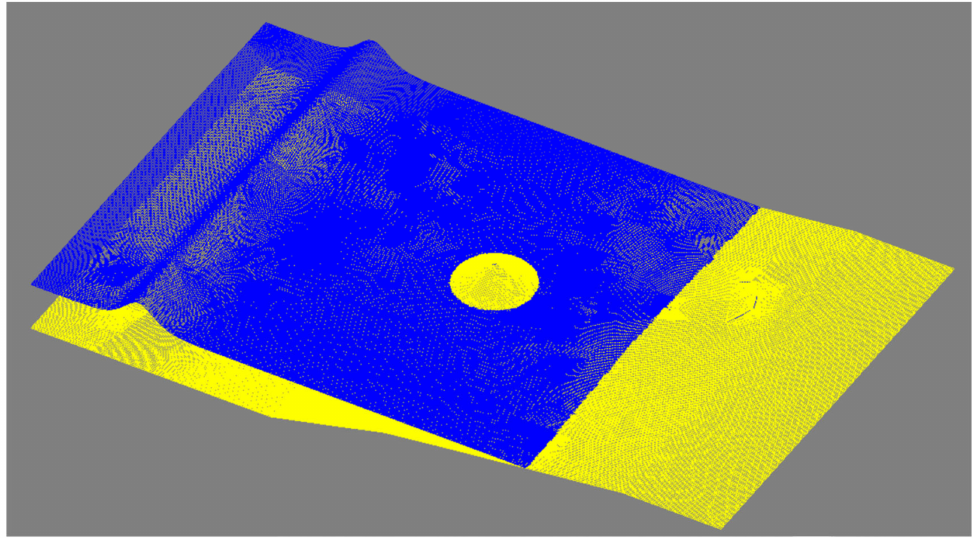
Figure 15. Snapshot of the initial setup of the simulation of a solitary wave transformation, breaking and runup over a three-dimensional